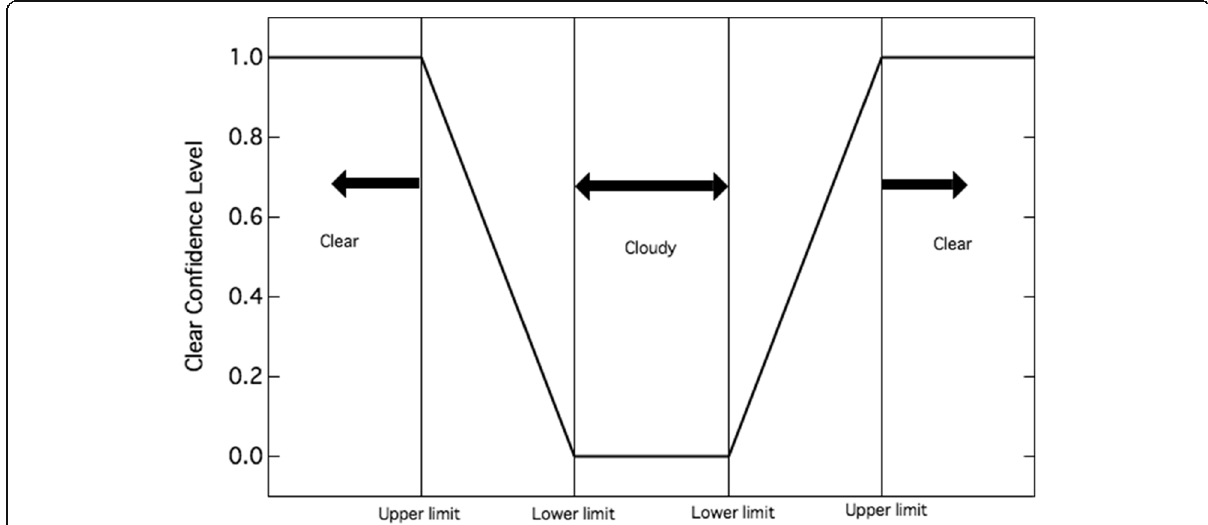
Fig. 3. Same as Fig. 1, except that the threshold testing uses two clear-sky ranges on both sides of a